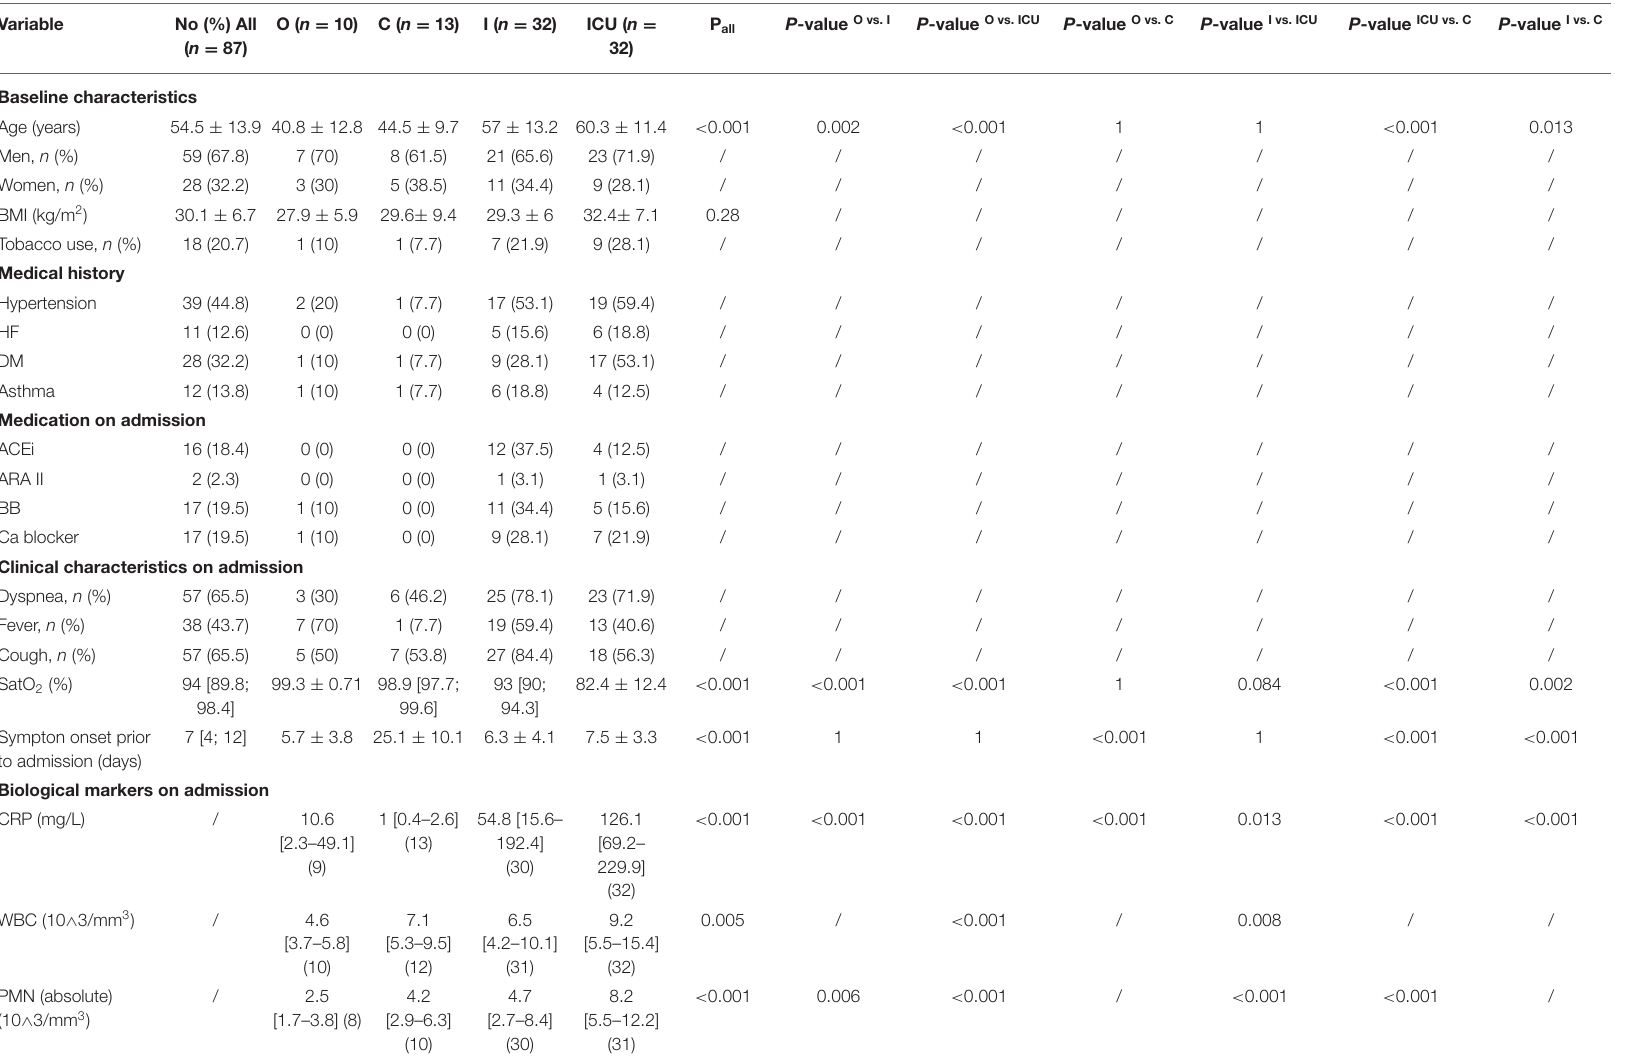
TABLE 1 | Baseline and clinical characteristics, anamnestic information, routine biomarkers and pneumoproteins on admission and outcome in our population.